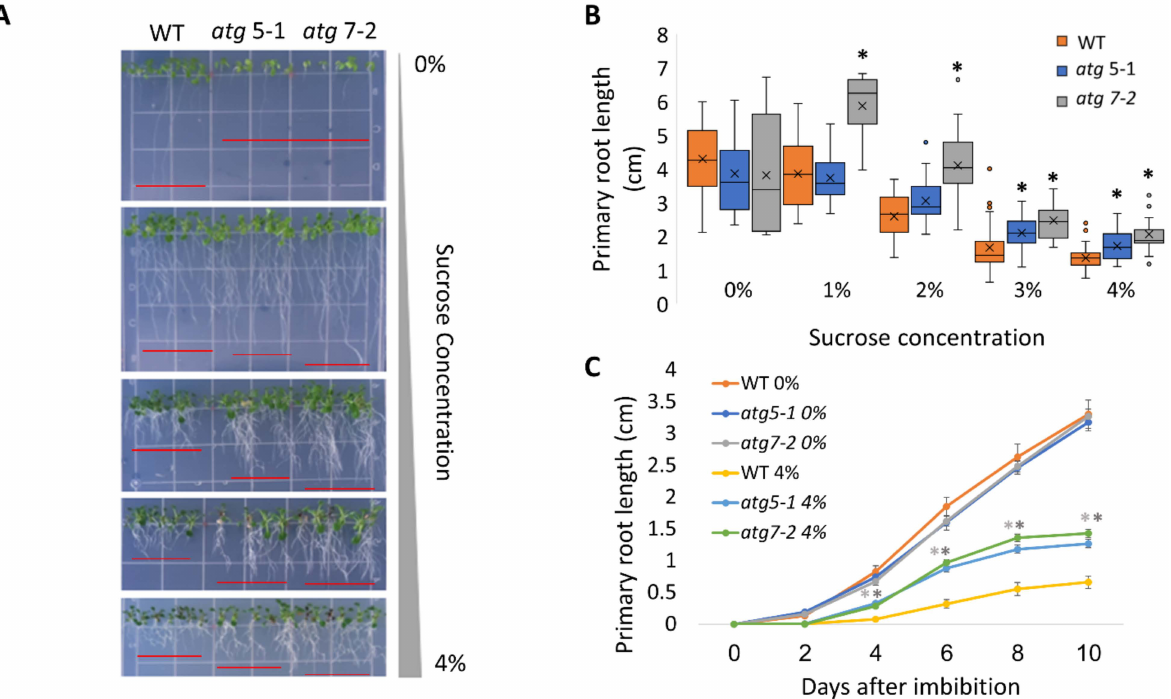
Figure 1. atg mutants display reduced sensitivity to sucrose excess. ( A , B ). WT, atg5-1 , and atg7-2 plants were sown on Nitsch plates containing increasing concentrations of sucrose, and grown vertically for 14 days. ( A ) Representative image of the plants. ( B ) Quantification of primary root length under various sucrose treatments. Asterisk denotes a significant difference from WT under the same treatment conditions, as determined by Dunnett’s test ( p < 0.05, n = 10–30), x indicates sample mean, and circles denote outliers. ( C ) WT, atg5-1 , and atg7-2 plants were sown on Nitsch plates containing 0% or 4% sucrose and grown vertically. The primary root length was measured every two days for 10 days after imbibition. Data are presented as the average ± SE. An asterisk denotes a significant difference from WT under the same treatment conditions and at the same time point, as determined by Dunnett’s test ( p < 0.05, n = 12–31). Dark grey— atg5-1 , light grey— atg7-2